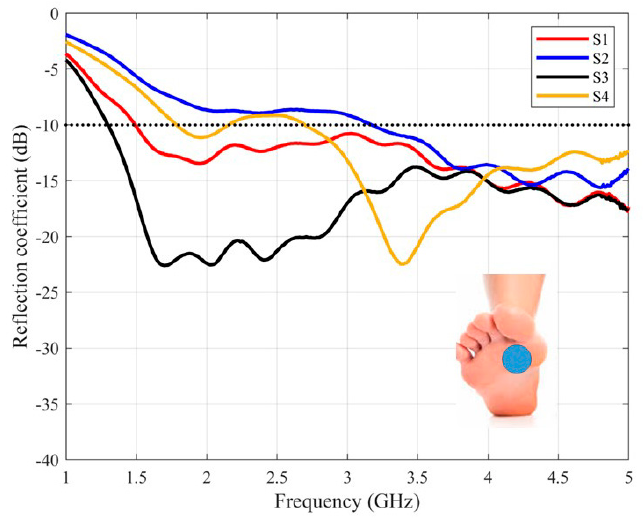
Figure 9. The measured reflection coefficients of the purposed antenna placed on the sole.